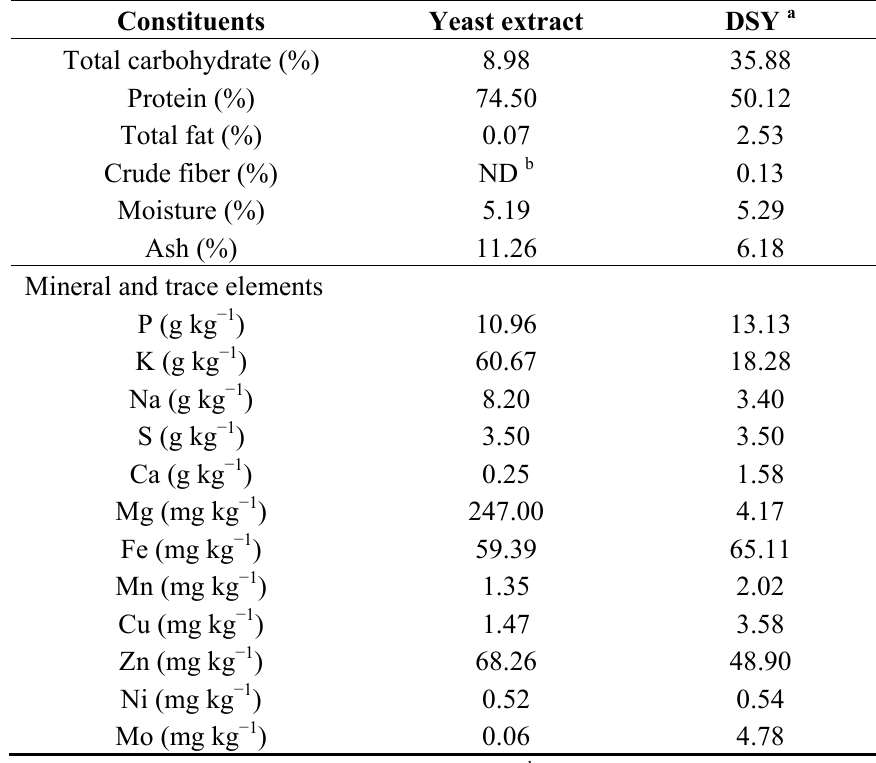
Table 2. The compositions of yeast extract (Himedia, India) and DSY (Beerthip Brewery (1991) Co., Ltd., Thailand).